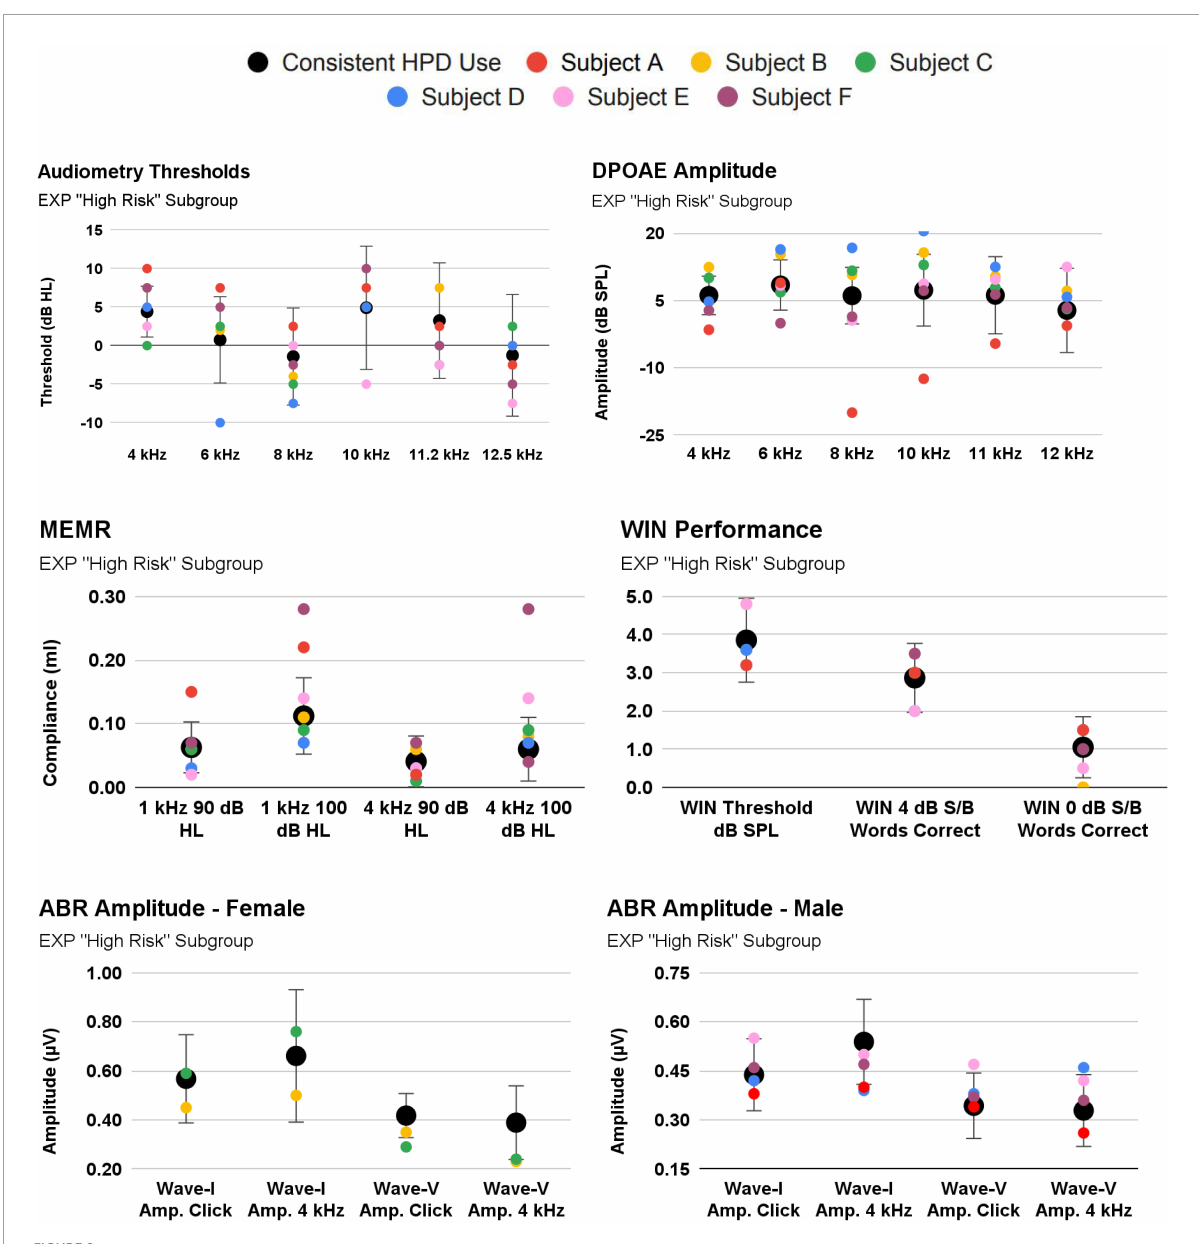
FIGURE8 3/33 EXP participants reported inconsistent use of hearing protection [Subject (A–C)]. Their audiologic responses are plotted against the EXP group mean [EXP mean calculated after omitting Subjects (A–C)]. Also shown are Subjects (D–F), as these they reported the highest occasions of firearm use (albeit, while wearing consistent hearing